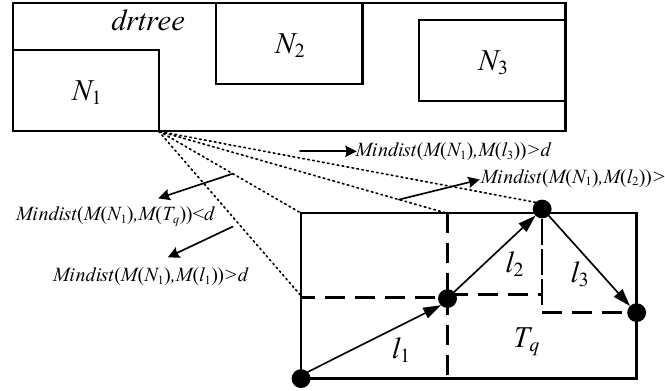
Figure 5. Example of Mindists of different data granularities.